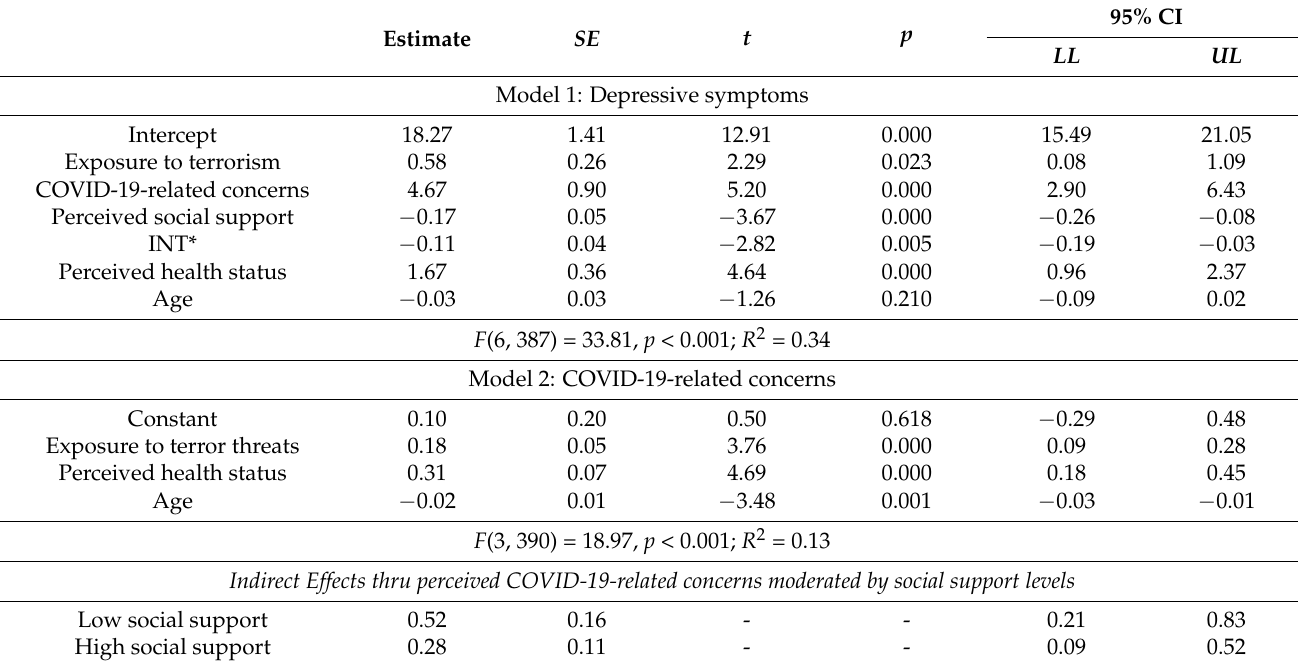
Table 2. Results for the Direct, Mediation and Moderation Effects of Exposure to Terrorism, COVID-19- Related Concerns, Perceived Health Status, Age and Perceived Social Support on Depressive